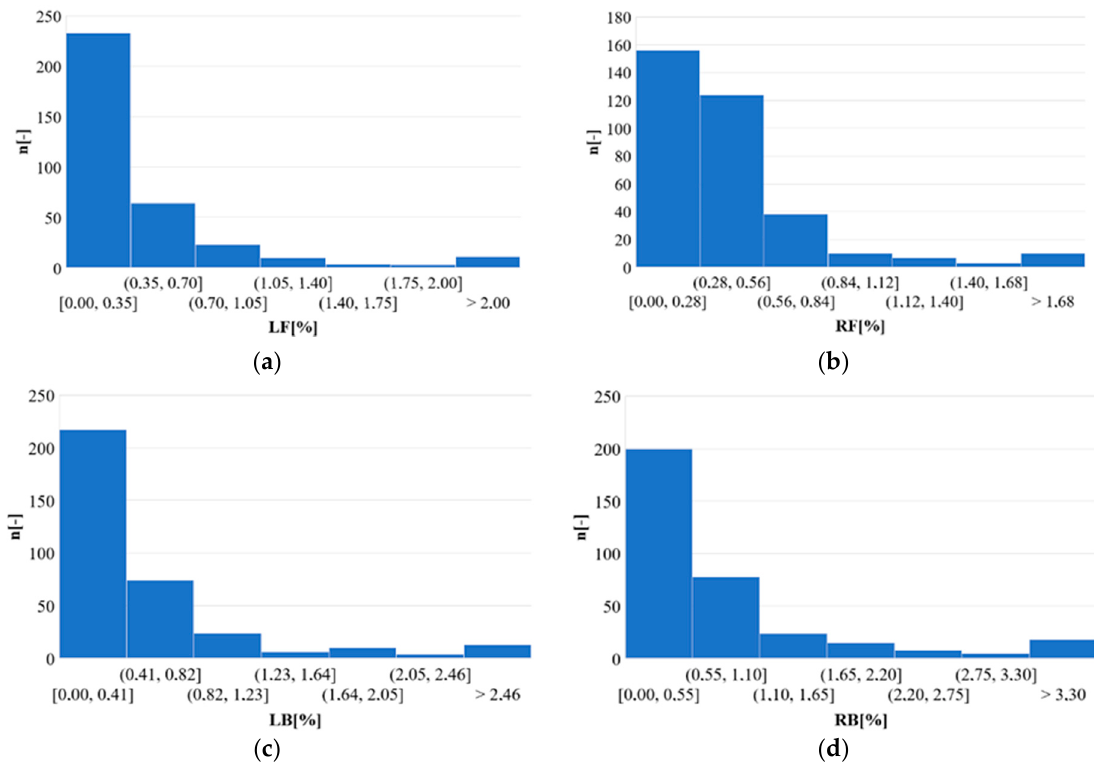
Figure 12. Histogram values of: ( a ) LF, ( b ) RF, ( c ) LB, ( d ) RB.